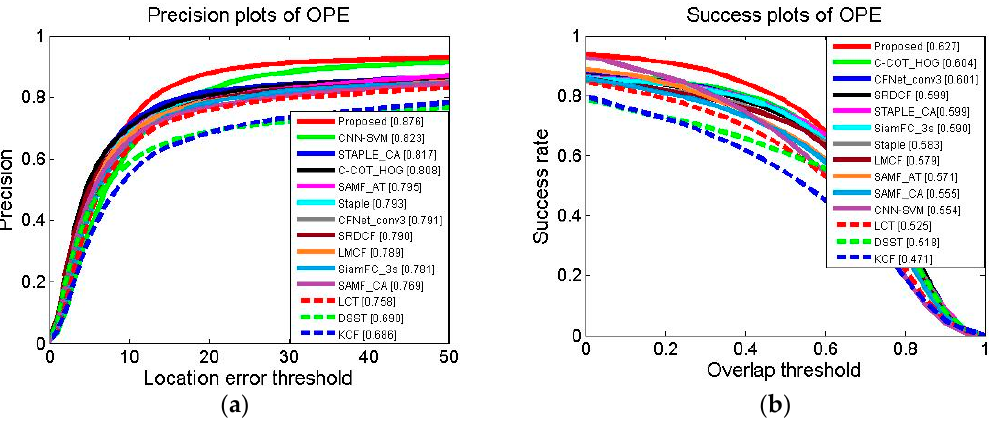
Figure 4. The overall tracking performances of precision ( a ) and success plots ( b ) comparing the proposed tracker with state-of-the-art trackers on OTB-100 using OPE evaluation. The proposed tracker performs well against these algorithms.